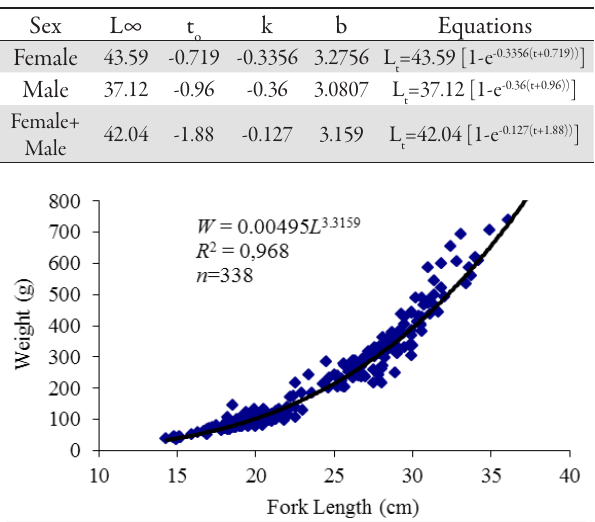
Tab. 4. von Bertalanffy length increase parameters for S.